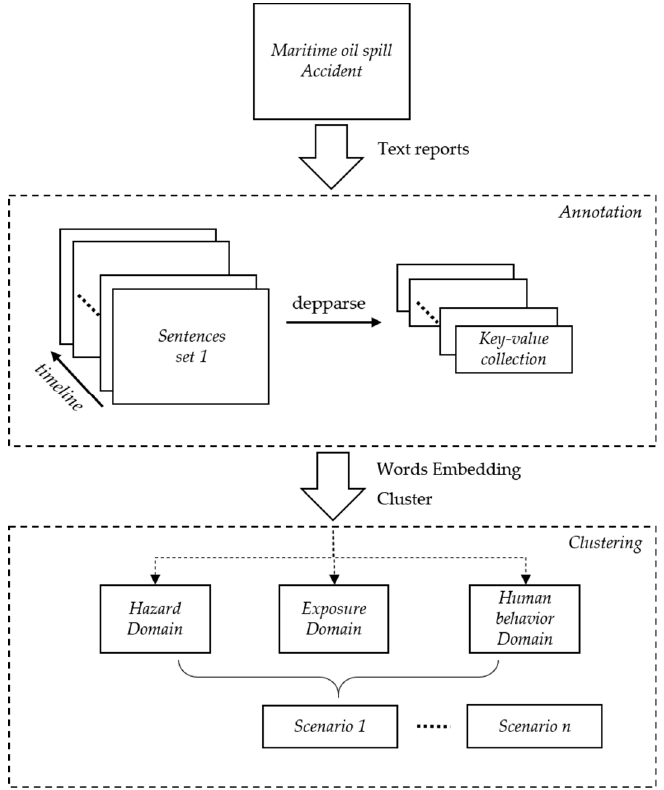
Figure 3. Overview of the scenario construction framework .